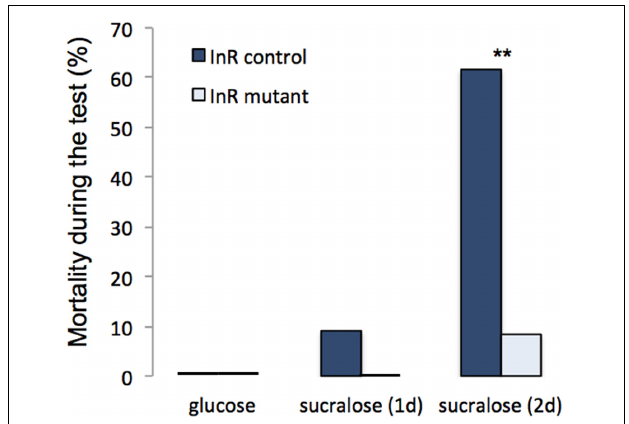
FIGURE 4 | Mortality of InR mutant and control flies during the feeding experiment when previously fed with glucose or with sucralose for 1 or 2 d. Asterisks show a difference in the mortality between the two groups of flies (Chi 2 -test, χ = 7 . 37, df = 1, p = 0 .